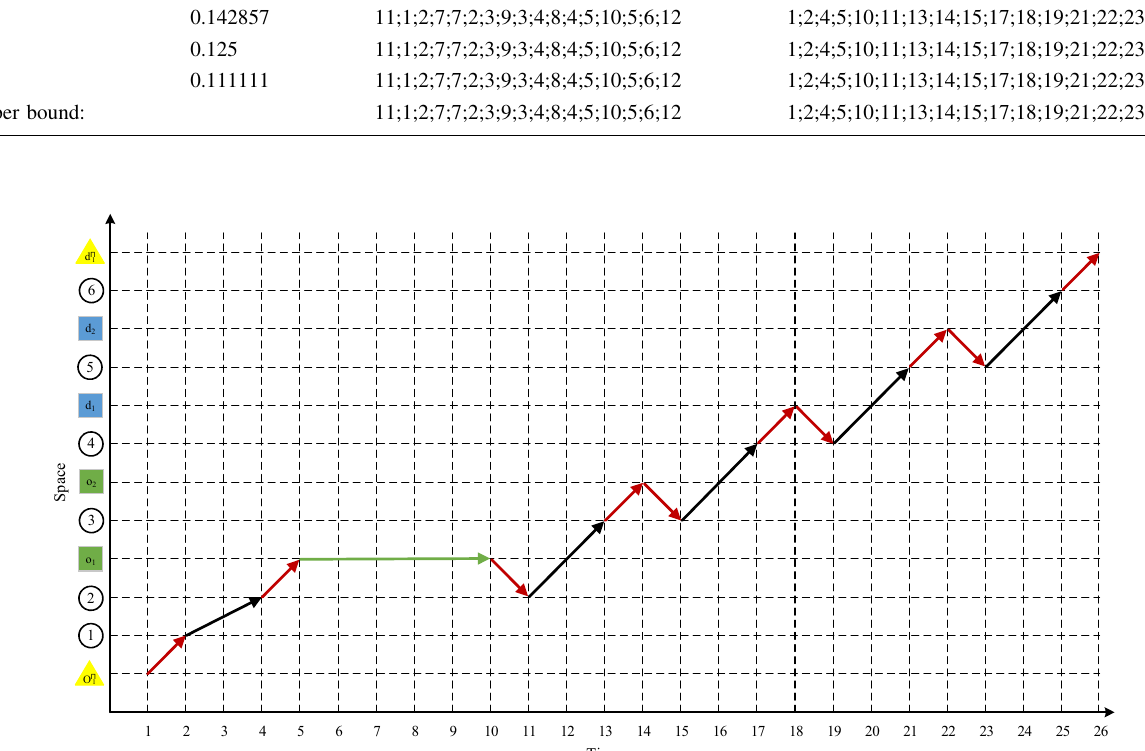
Fig. 12 Space–time trajectory of the vehicle for the example with extra vehicle waiting